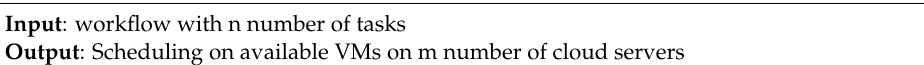
Algorithm 1: Proposed MONWS